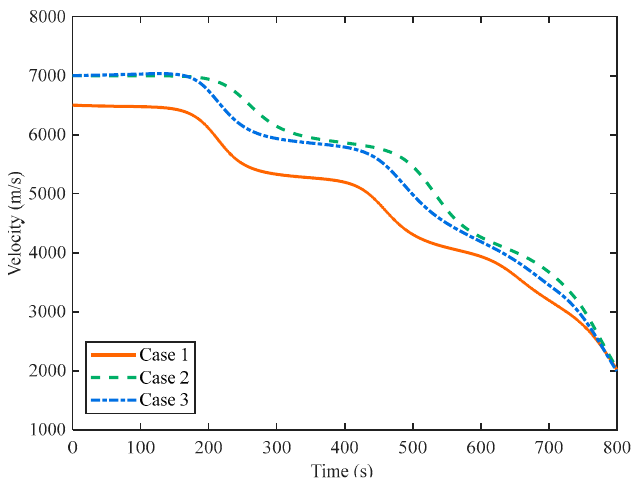
Figure 16. Time histories of the velocity.